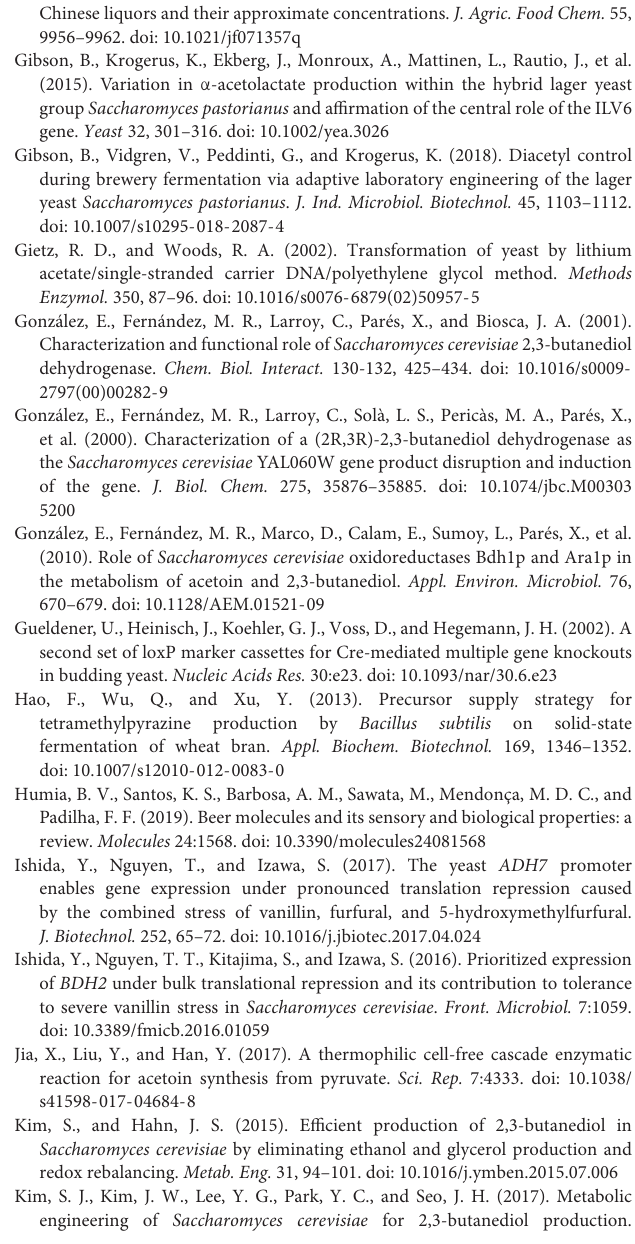
Supplementary Figure 1 | Growth curve of haploid strains and diploid strains. Supplementary Table 1 | Primers used in this study. Supplementary Table 2 | The recombinant fragments and corresponding PCR